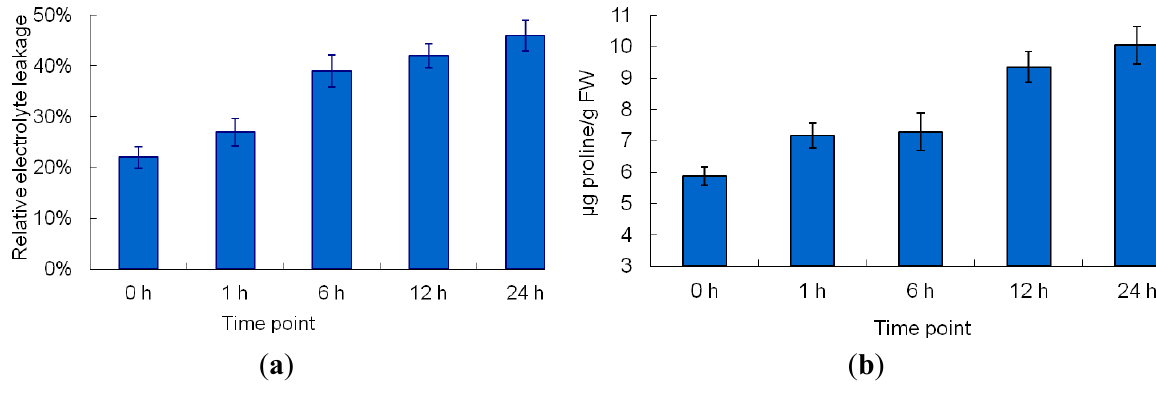
Figure 3. Physiological responses of maize leaves to Cr stress treatment. Maize seedlings were watered with 300 mg/L potassium dichromate for 24 h and the REL ( a ) and proline concentration ( b ) were measured at 0, 1, 6, 12, and 24